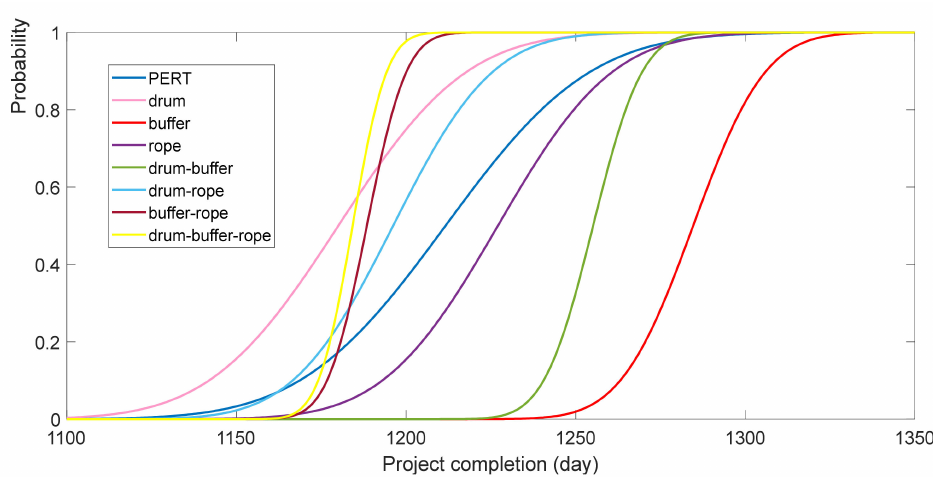
Figure 6. Simulation comparison of completion probability between different